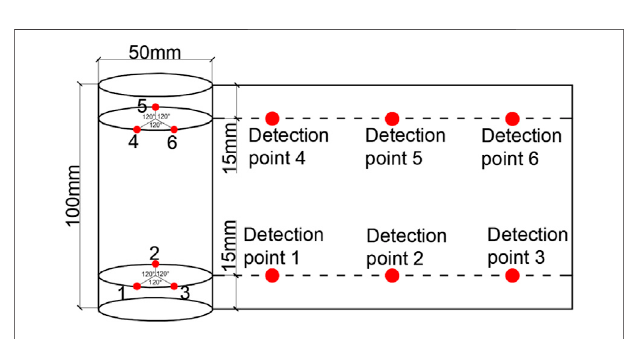
FIGURE 5 | Layout of an acoustic emission probe.